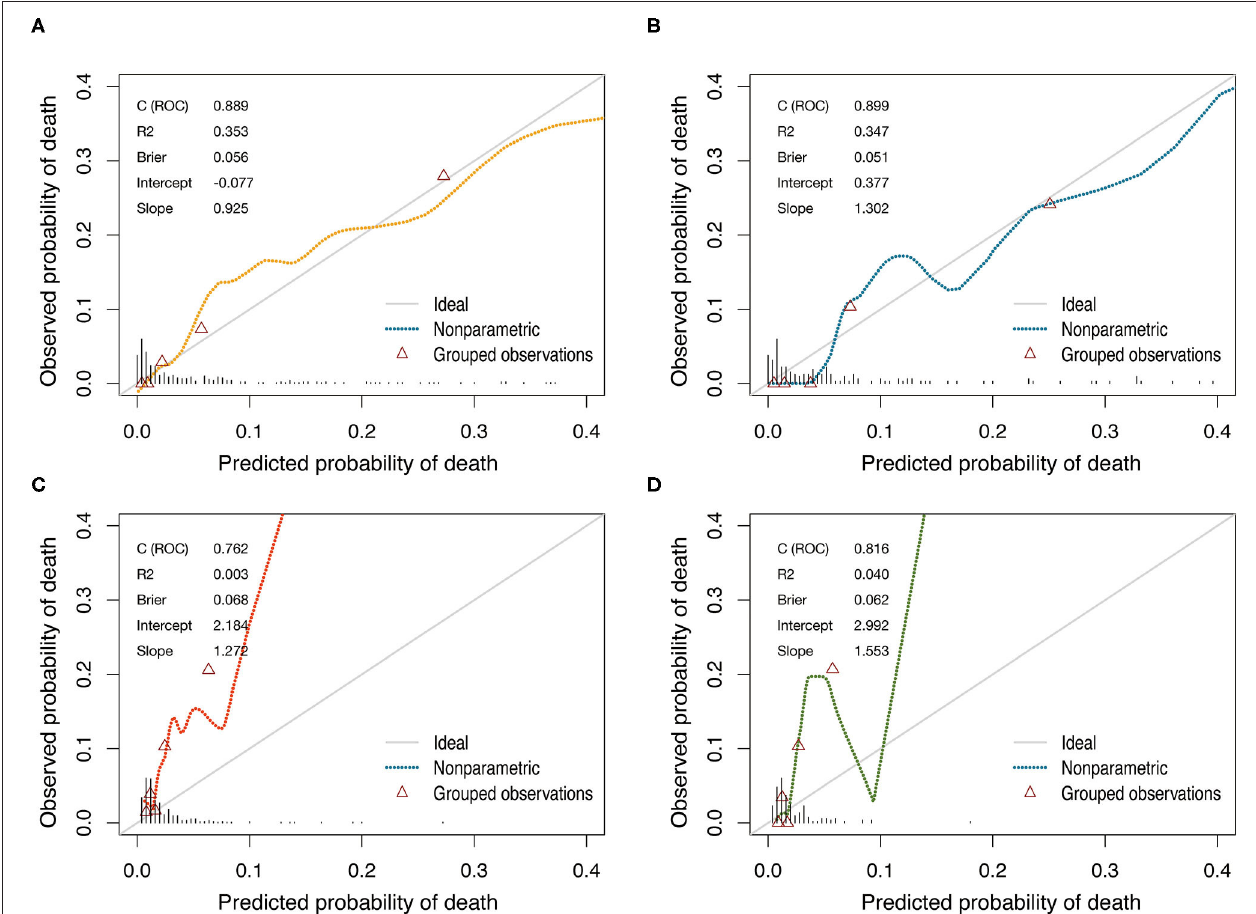
FIGURE 3 | Calibration curves of the nomogram and the EuroSCORE-2 for predicting mortality after CABG in training cohort and validation cohort. (A) The nomogram in training cohort. (B) The nomogram in validation cohort. (C) The EuroSCORE-2 in training cohort. (D) The EuroSCORE-2 in validation cohort. Diagonal line indicates perfect calibration. The triangles indicate the observed frequencies of death by the quintiles of the predicted probability.